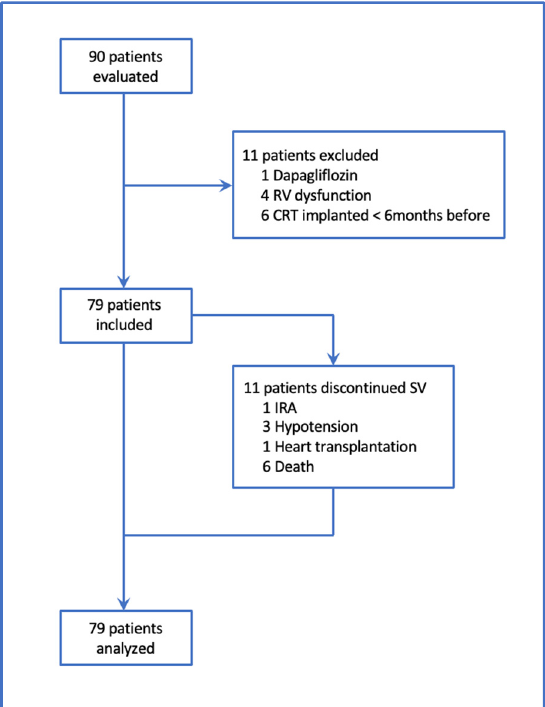
Figure 1. Enrollment of study population. From 90 patients evaluated at the beginning of the study, 11 were rolled out because of exclusion criteria. 79 patients were analyzed, 11 of them discontinued sacubitril/valsartan (SV) before the end of the study.